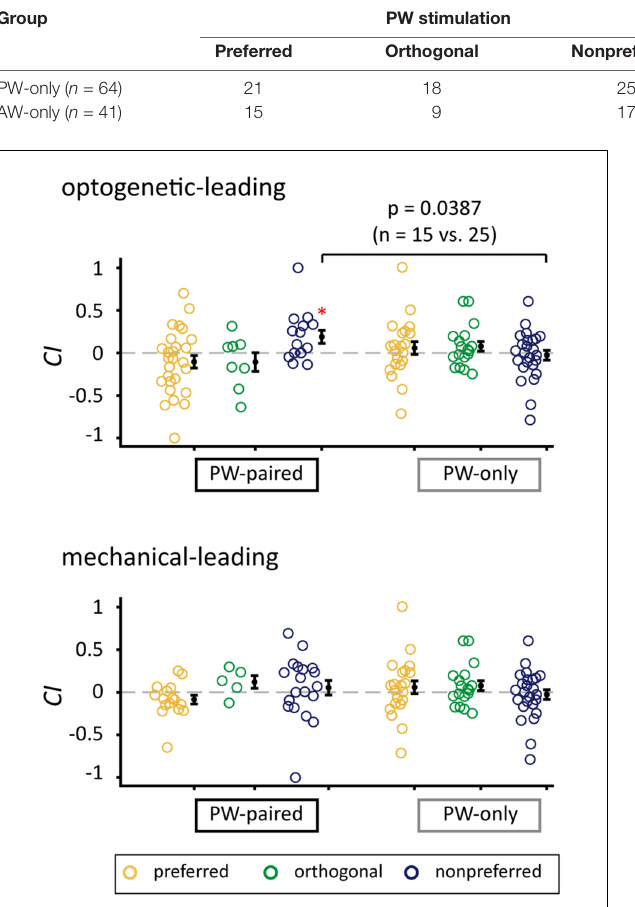
FIGURE 7 | Comparison of CI s between the PW-paired and PW-only groups. Comparison of CI s for PW stimulation between the PW-paired and PW-only groups. Single units in the PW-paired group receiving the optogenetic-leading (upper panel) and mechanical-leading (lower panel) conditions were analyzed separately. The CI s in the nonpreferred condition in the optogenetic-leading condition in the PW-paired group were significantly higher than those in the PW-only group ( p < 0.05, Wilcoxon rank-sum test). ∗ for p < 0.05/3 as in Figure 5B .